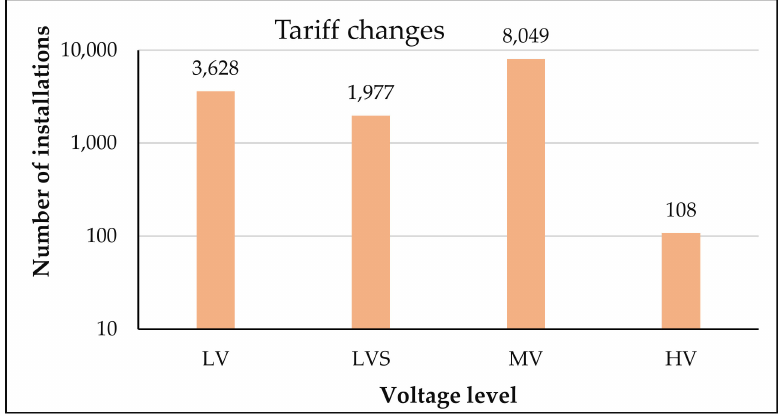
Figure 2. Distribution of consumers who change their tariff contract.